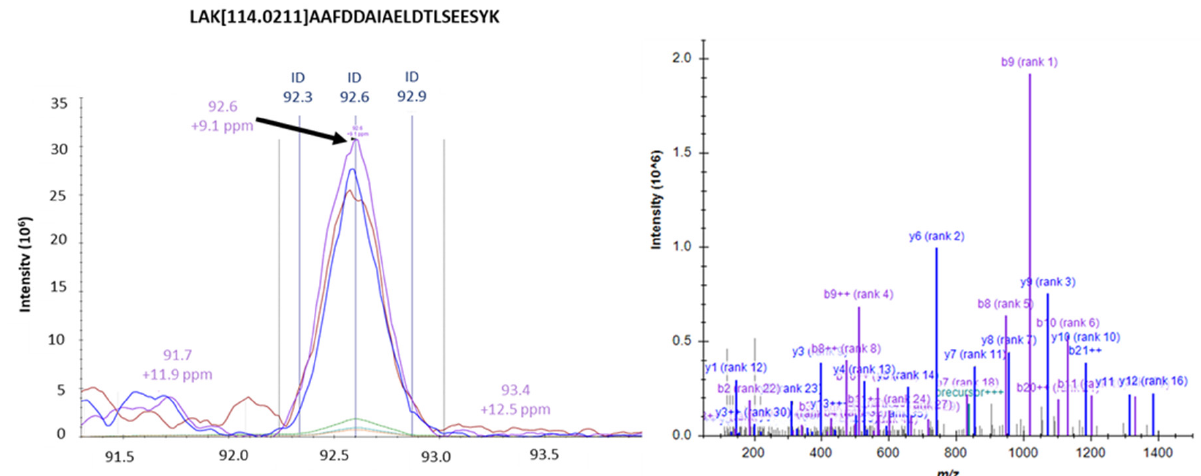
Figure 5. Elution profile and spectral identification of a K-glycated AGE peptide identified by high-resolution mass spectrometry.